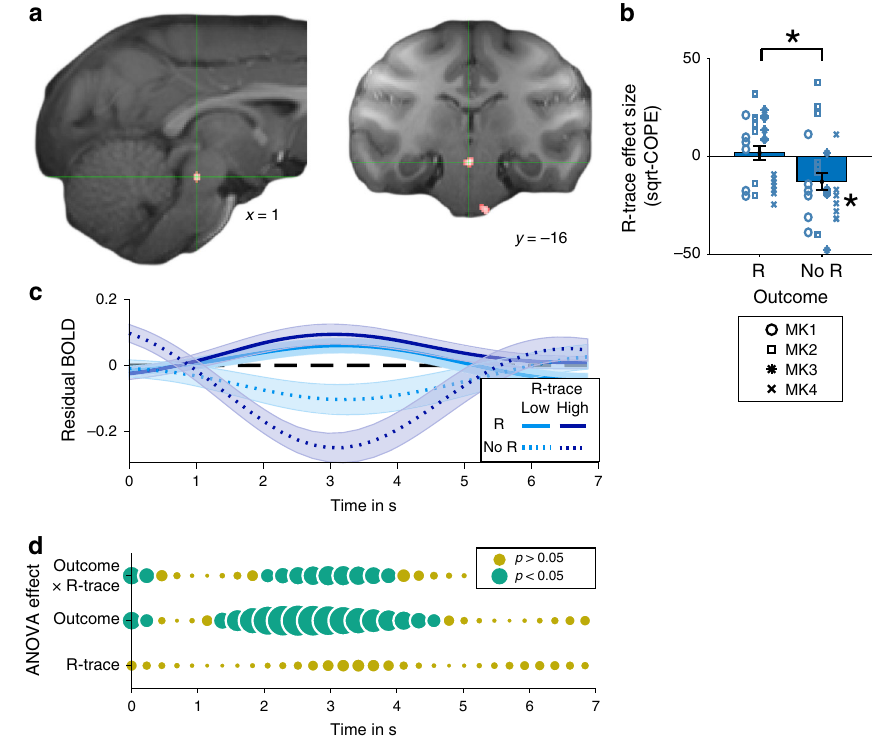
Fig. 8 R-trace and outcome signals in DRN. a During unrewarded trials, DRN encoded R-trace negatively. This effect is shown at z > 3.3 for spatial speci fi city. Reward feedback occurs at time 0 s and the approximate peak of the macaque hemodynamic response function is 3 – 4 s later. b This was not the case during rewarded trials (reward/no reward: R and no R). We used two-sided paired t-tests to assess the difference in activation ( p = 0.007). The asterisk for no R refers to the whole-brain analysis performed in panel a . ROIs were selected using a leave-one-out procedure. c , d Time course analyses of DRN activity related to outcome and R-trace coding. Same conventions as in Fig. 7. (Crosshairs highlight peak coordinates for subsequent ROI analysis; data are presented as mean values ±SEM across sessions; n = 25; dot color in b indicates monkey identity; all MRI results cluster-corrected at Z > 2.6, p = 0.05; asterisks indicate p < 0.05). Source data are provided as Source Data fi le. Symbols indicate monkey identity in panel b ; MK abbreviates